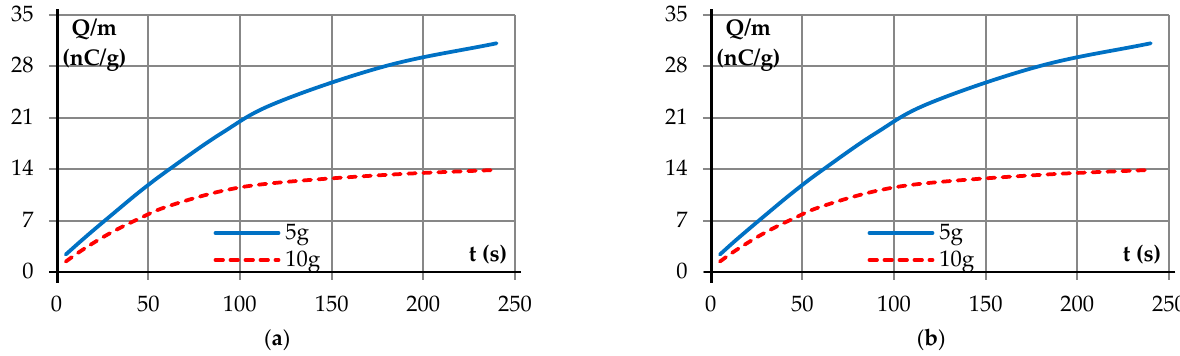
Figure 11. Charge density per mass as a function of time t tribocharging in a PET-G container for PE-HD with fraction ( a ) 1.8–2.8 mm and ( b ) 2.8–4 mm at airflow V = 1.6 cpm.